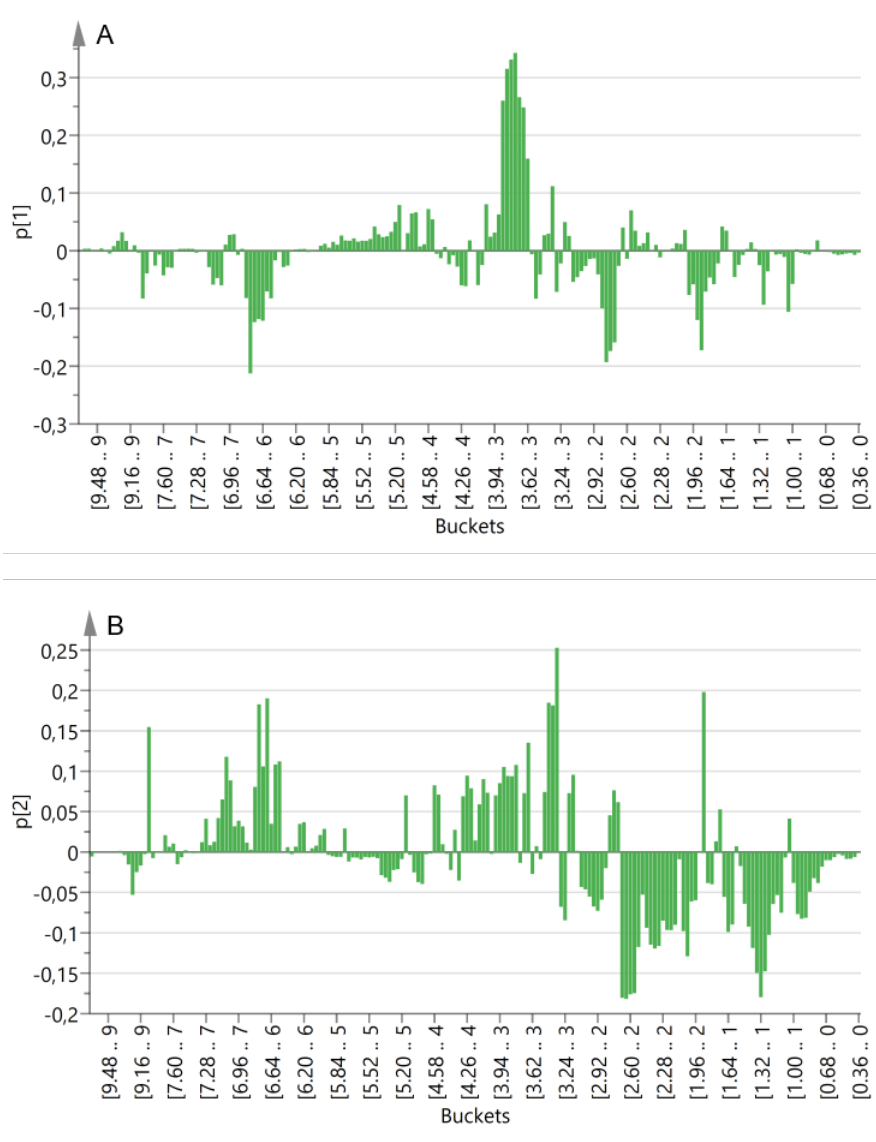
Figure 2. PCA loading plots: ( A ) PC1 and ( B ) PC2.